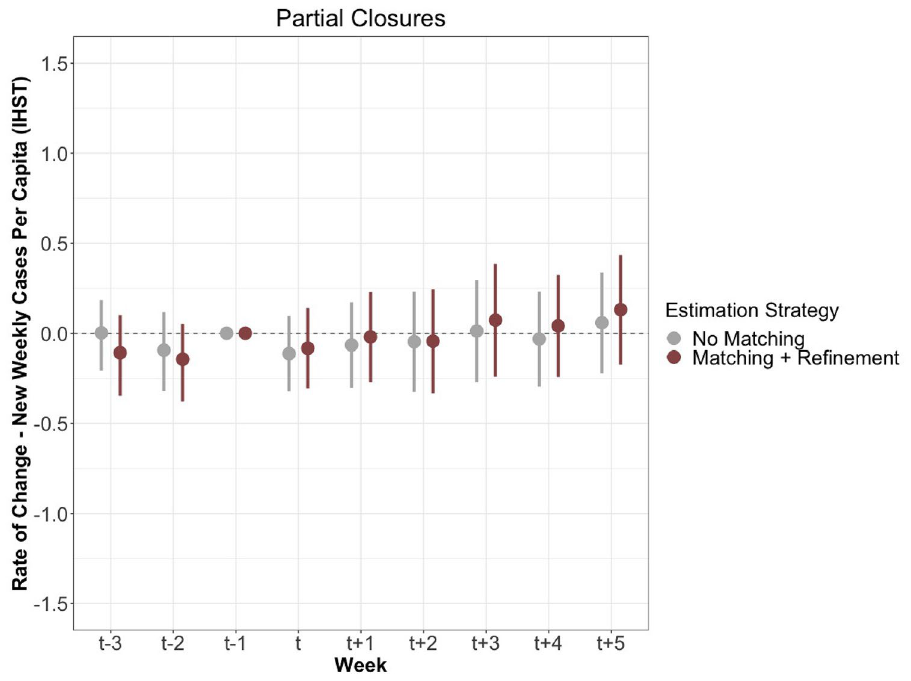
Figure 4. This figure shows the measured effects of partial closures on the rate of change of new cases per capita after IHST (y-axis). The estimates in grey were generated with neither matching nor refinement, while the red estimates were generated with matching and refinement, both displayed with 95% confidence intervals. The optimal refinement strategy selected is covariate balancing propensity score matching. The period includes nine weeks: three prior to the border closure, the week of the closure, and five following the closure.